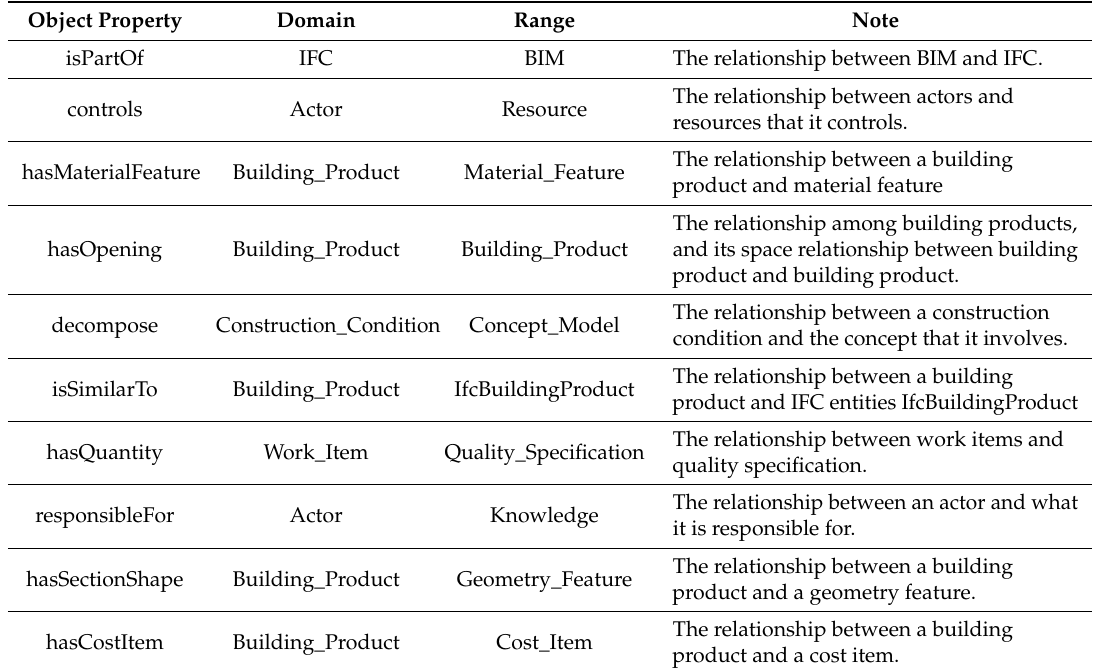
Figure 7. General integration architecture of the cost estimation model. Table 2. Examples of object properties of the cost estimation ontology.